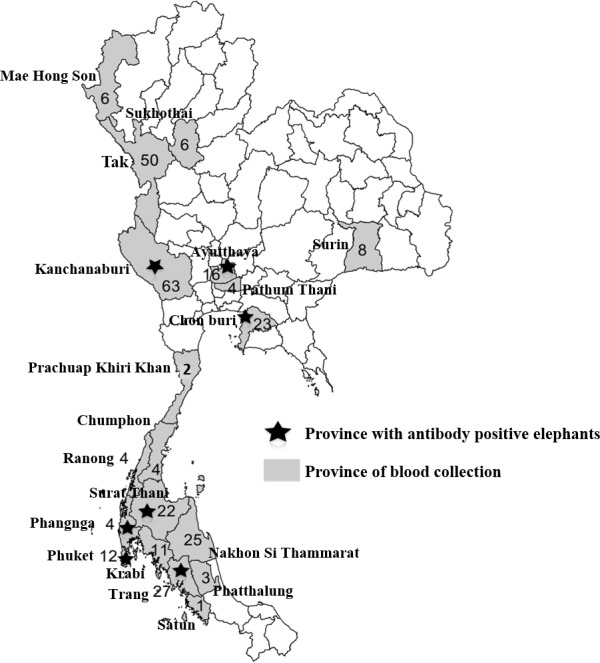
Geographical distribution of domestic elephants infected with H1N1pdm virus in Thailand.